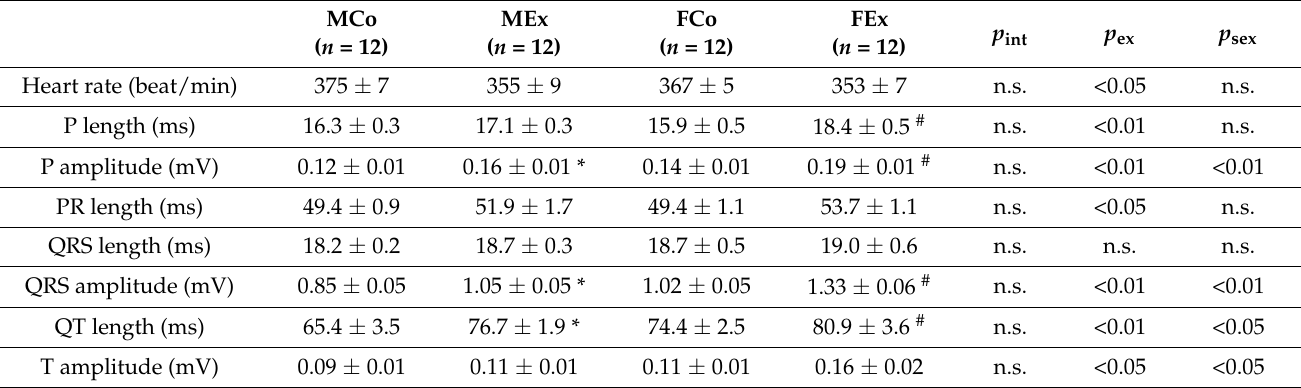
Table 1. Electrocardiogram (ECG) data (lead II). * p < 0.05 vs. MCo; # p < 0.05 vs. FCo. Data are expressed as mean ± SEM. Two-way ANOVA exercise ( p ex ) and sex ( p sex ) interaction ( p int